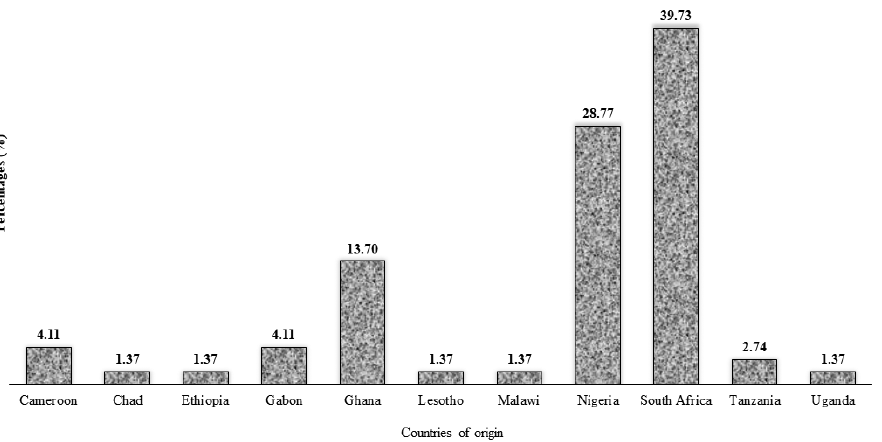
Figure 2. Distribution of study participants ( n = 73) by country of origin. There were few smokers (12.3%), and nearly all the participants reported they had been vaccinated for other conditions, mostly yellow fever, tuberculosis, polio, and hepatitis, which are shown in Figure 3.